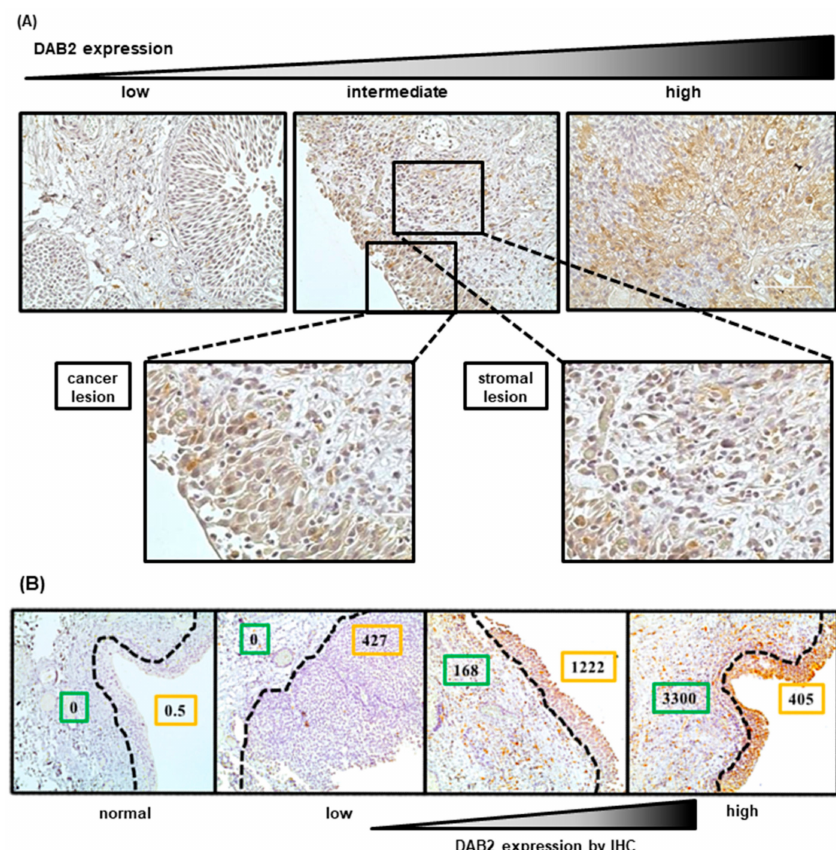
Figure 1. ( A ) Immunohistochemical staining for Disabled homolog-2 (DAB2) revealed that DAB2 was expressed mainly in the cytoplasm of cancer and stromal cells. Scale bars, 200 µ m. ( B ) DAB2 mRNA expression levels as determined by RT-qPCR in cancer and stromal tissues separated by microdissection. The stronger the immunohistochemical staining of DAB2, the higher the DAB2 mRNA expression in cancer and stromal tissues, respectively. Green line: stromal lesion, orange line: cancerous lesion, Dotted line: resection line of microdissection, IHC: Immunohistochemical staining. Table 1. Clinicopathological characteristics of 212 patients with bladder cancer undergoing transurethral resection of the bladder tumor stratified by DAB2 expression level in the cancerous area. DAB2 Expression Number of Patients p -Value † (%)